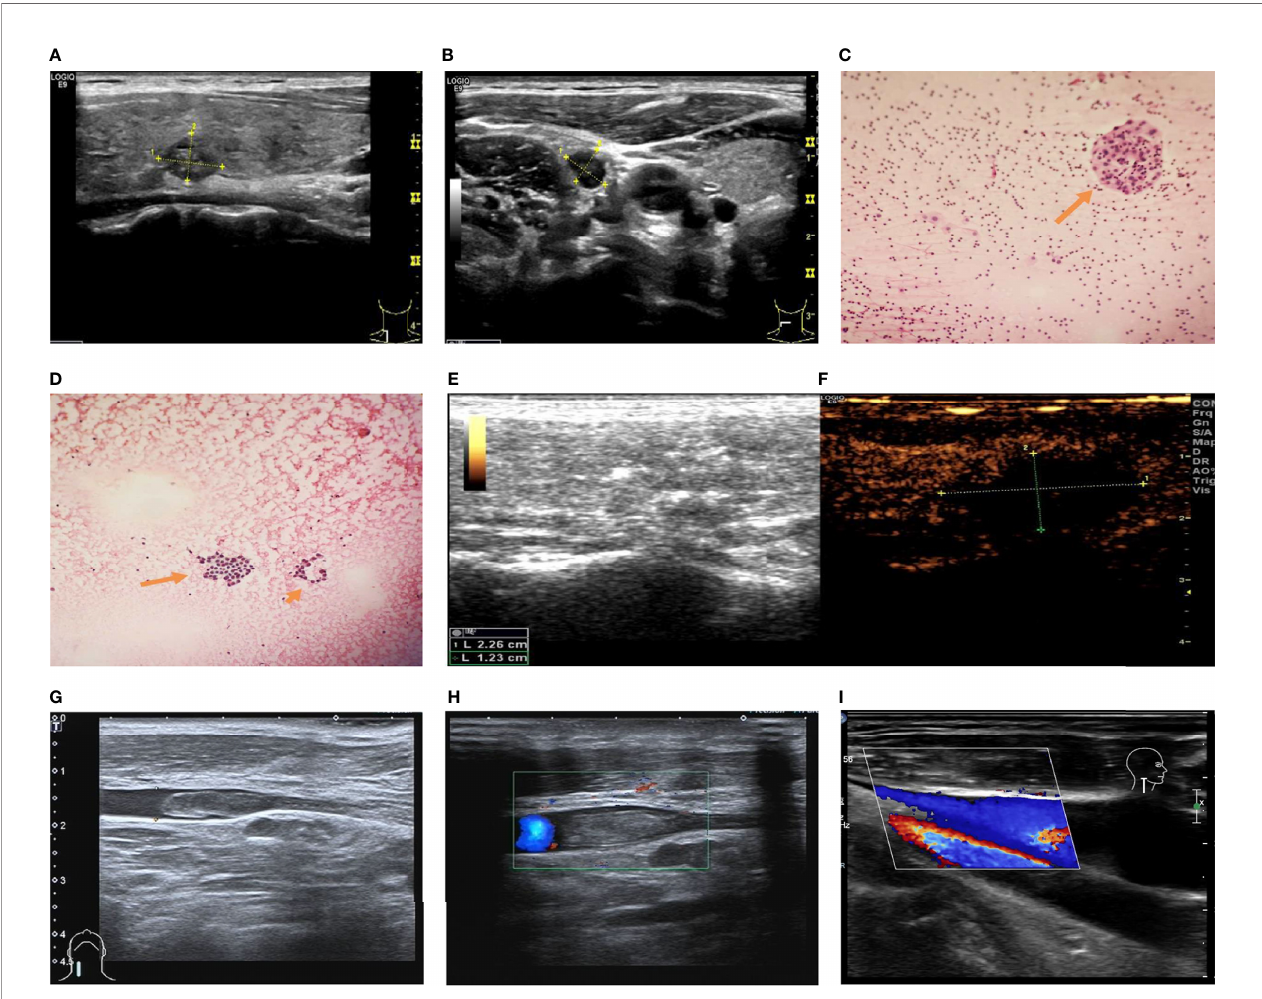
FIGURE 1 | Ultrasound and fl ow chart of Patient #1 after ablation. (A) Preoperative ultrasound of thyroid nodule. (B) Preoperative ultrasound of lymph node. (C) Thyroid FNA smear: epithelial cells with dysplasia (arrow). (D) Cervical lymph node FNA smear: lymphocytes and epithelial cells with dysplasia (arrow). (E, F) Ultrasound after extended ablation of papillary thyroid carcinoma of the right lobe of thyroid of the patient immediately after postoperative (local no contrast medium fi lling). (G) Two-dimensional ultrasonography of internal jugular vein thrombosis on the second day after ablation. (H) Thrombus fl ow diagram of the right internal jugular vein on the second day after ablation. (I) One month after thrombolysis, venous thrombosis disappeared, and venous blood fl ow returned to lymph node metastasis, galectin-3 (+), Ki67 (+), MC (+), CD56 (-), and CK19 (+).